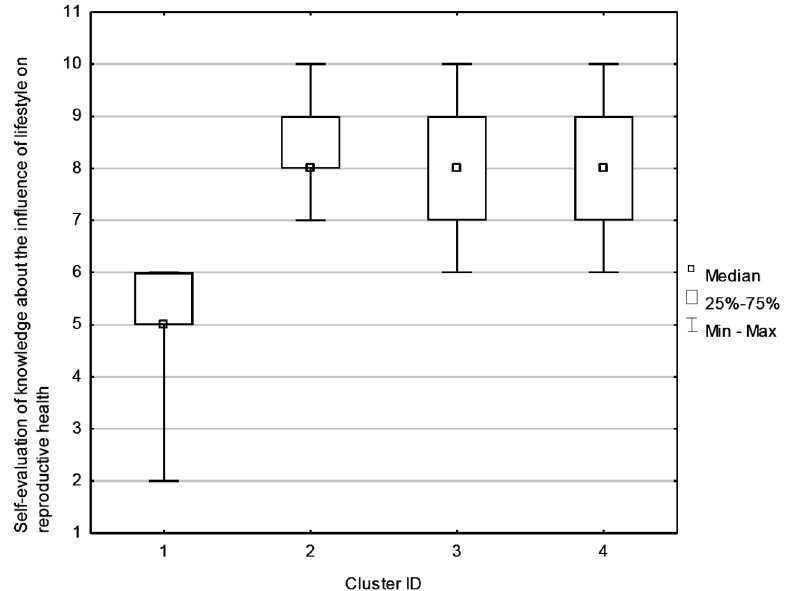
Figure 2. Level of declared knowledge about the impact of lifestyle on repro- ductive health for each of the